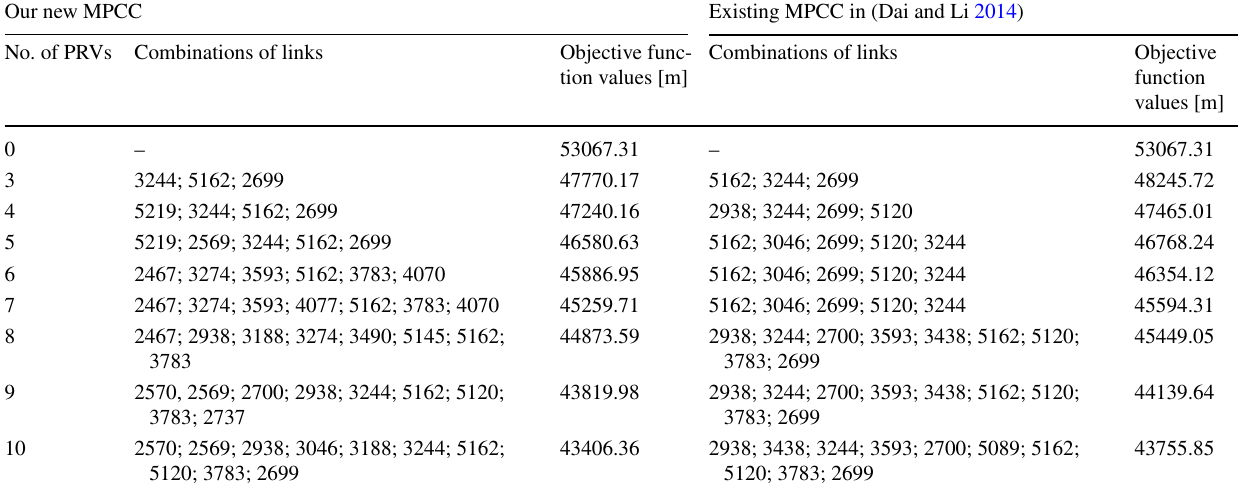
Table 4 Optimal PRV locations for the EXNET network Our new MPCC Existing MPCC in (Dai and Li 2014)